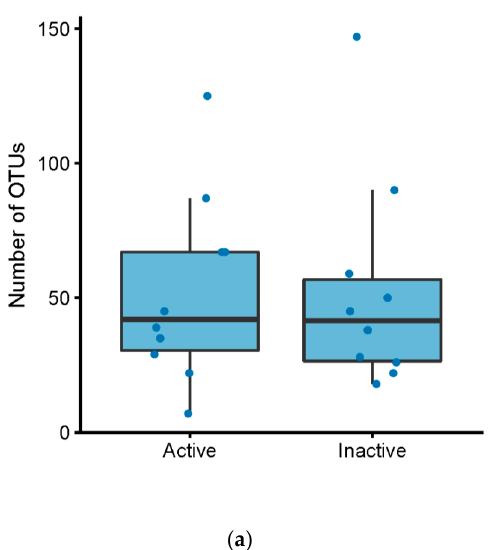
Figure 1. ( a ) Number of OTUs in patients with an ileo-anal pouch anastomosis, with active vs. inactive pouchitis. Active pouchitis was defined as a modified pouchitis disease activity index (mPDAI) score of 3 or above. ( b ) Shannon diversity index in patients with an ileo-anal pouch anastomosis, with active vs. inactive pouchitis. Active pouchitis was defined as a mPDAI score of 3 or above.